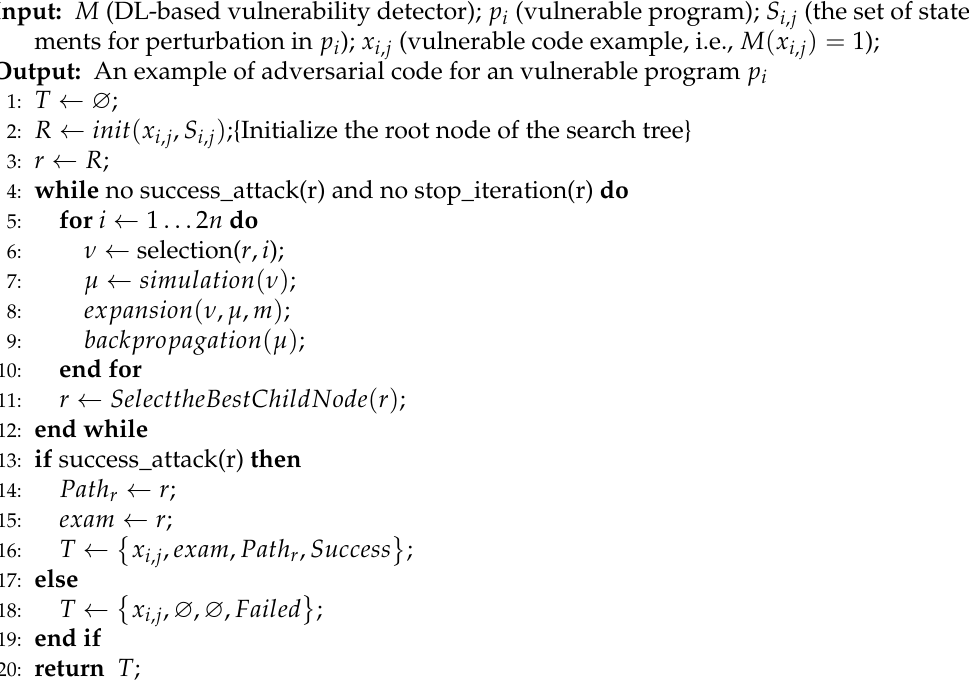
Algorithm 3 Generating adversarial